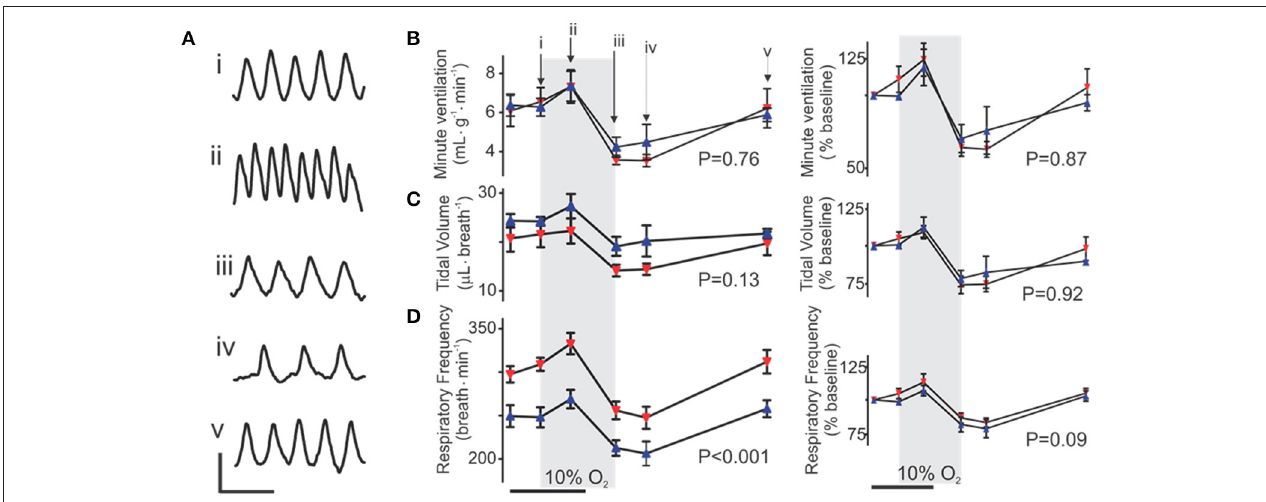
FIGURE 6 | Following CIH respiratory frequency is increased in vivo . (A) Representative plethysmography traces from a control mouse illustrating the changes to frequency during the peri-hypoxic interval. Scale Bars: 500 ms (horizontal); 20 µ L (vertical) Comparison of (B) Minute Ventilation, (C) Tidal Volume (D) Respiratory Frequency between control and CIH exposed mice. In (B–D) left shows absolute values, right shows normalized values. Each metric was normalized to each respective baseline metric while breathing air 2 min before hypoxic exposure.